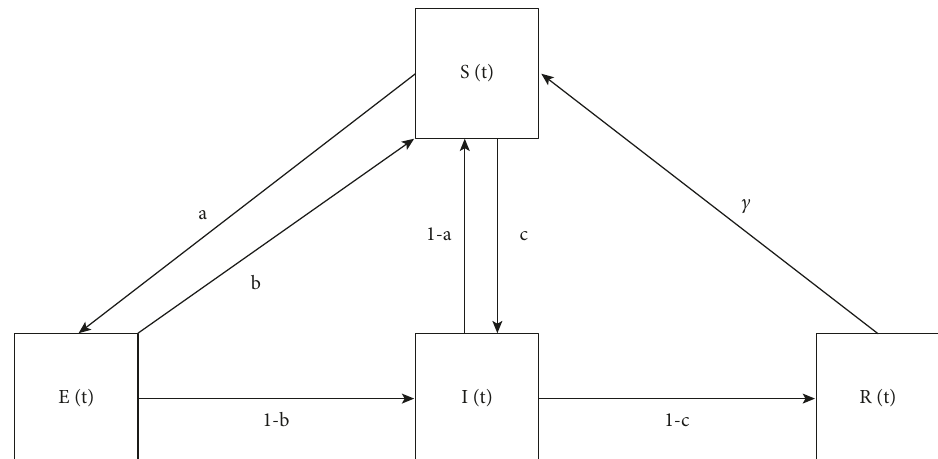
Figure 1: Credit risk contagion process of financial guarantee